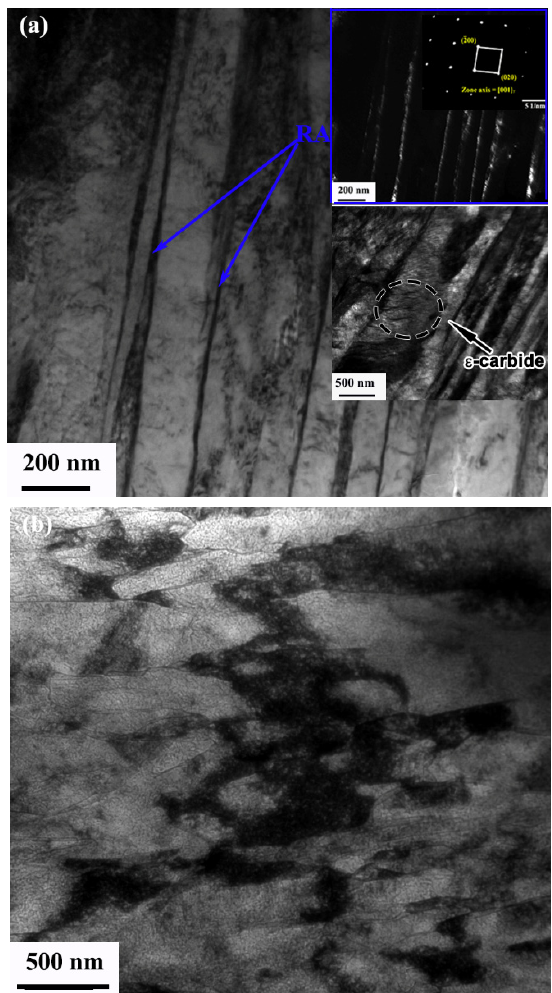
Figure 2. TEM micrographs of 22MnSi2CrMoNi ( a ) and 00Ni18Co9Mo4Ti ( b ) steel (RA: Retained Austenite).